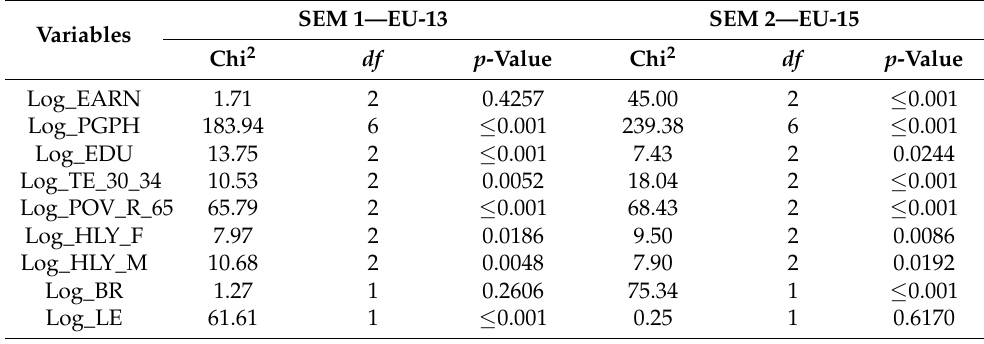
Table A4. Wald tests for equations associated with the SEM models, 1995–2017.